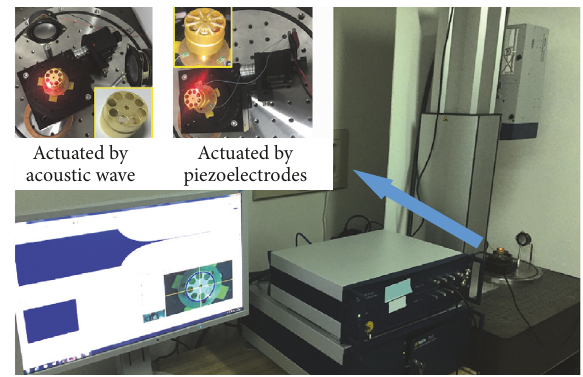
Figure 5: The experimental system.